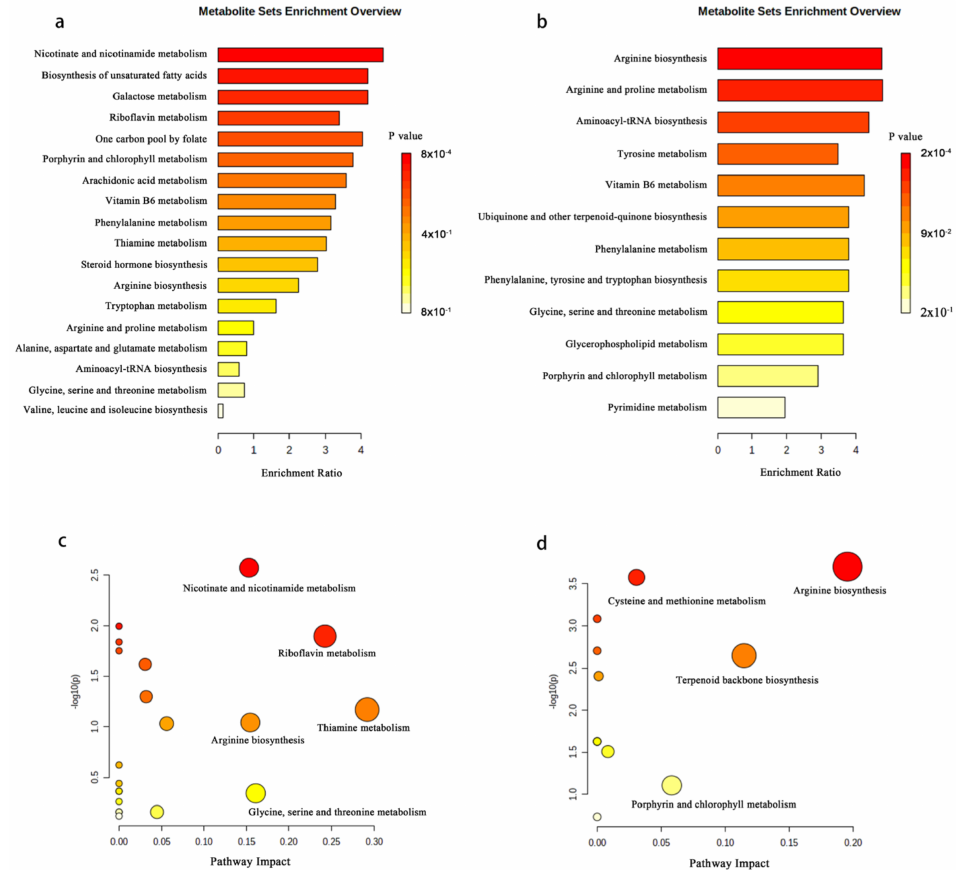
Figure 6. ( a , b ) Differentially expressed metabolic pathway maps of OSBSz and OSBSh. ( a ) Widely targeted metabolomics. ( b ) Untargeted metabolomics. ( c , d ) Differentially expressed metabolite enrich- ment analysis of OSBSz and OSBSh. ( c ) Widely targeted metabolomics. ( d ) Untargeted